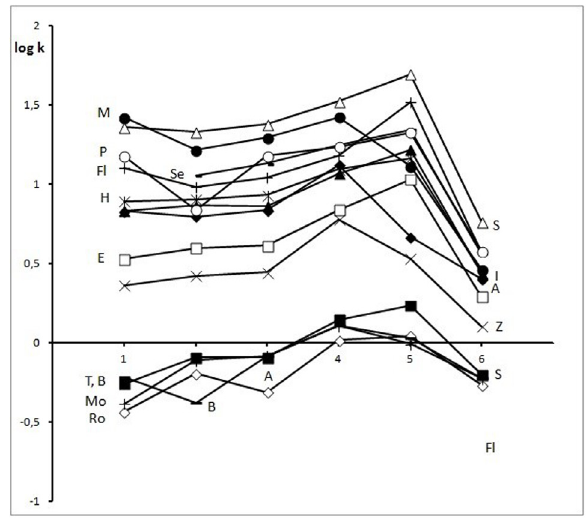
Figure 2: Graphical comparison of log k values of the psychotropic drugs on different columns with mobile phases containing as eluent 30% acetonitrile, 20%acetate buffer at pH 3.5 and 0.025 ML -1 DEA obtained on 1. C18, 2. Phenyl, 3. Phenyl-Hexyl, 4. Polar RP, 5. PFP and 6. CN